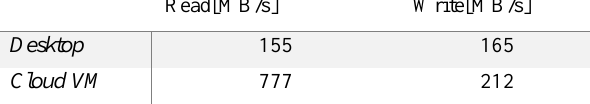
Table 2. Read & Write performance (mean value of 10 independent measurements) The higher performance of the cloud disk solution allows much faster access to the data sources and much faster writing of processed temporary and permanent results.